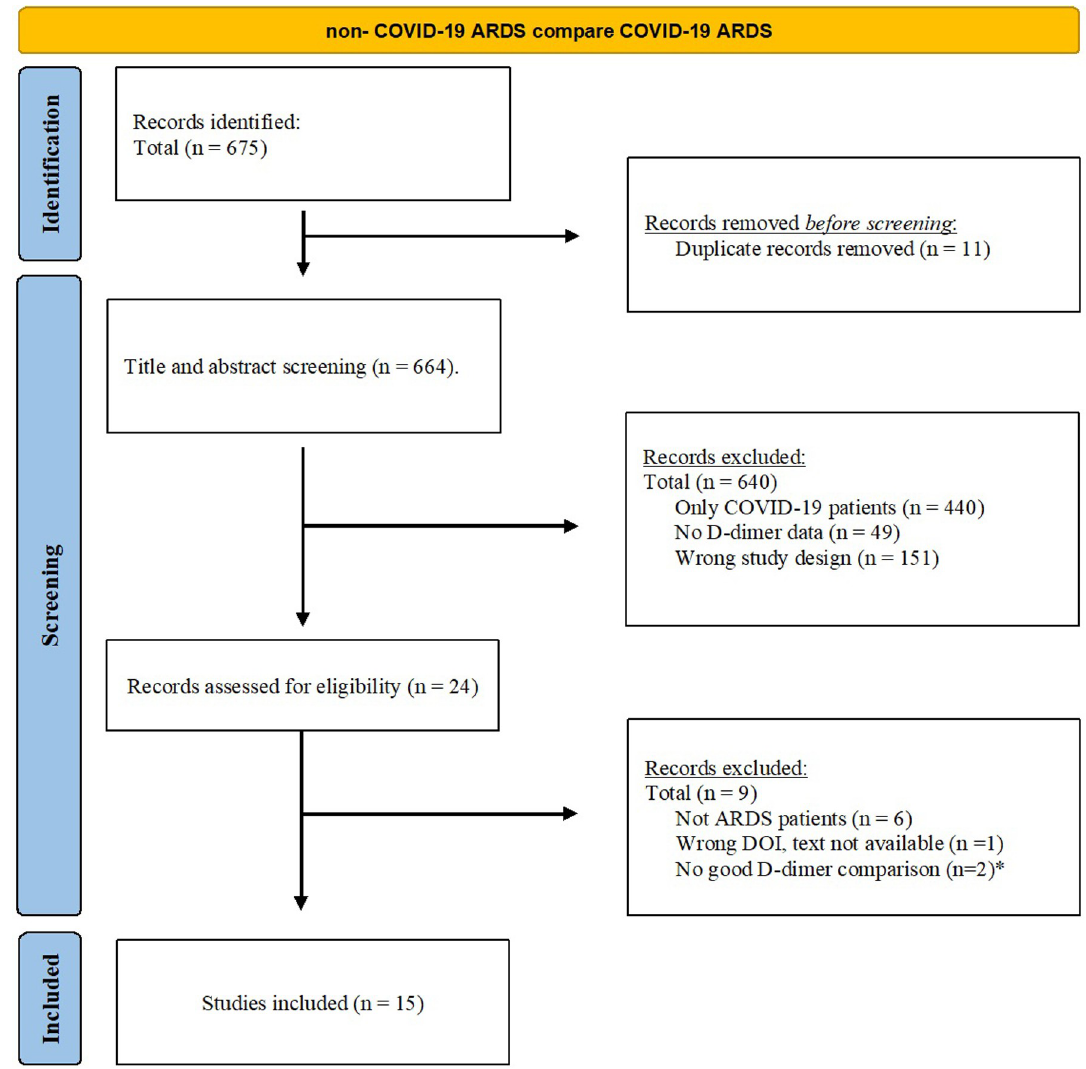
Fig 1. Flow chart. No good D-dimer comparison: In one case (G. Grasselli) they only reported D-dimer in COVID patients and in the other case (P. Sinha) there were no non-COVID